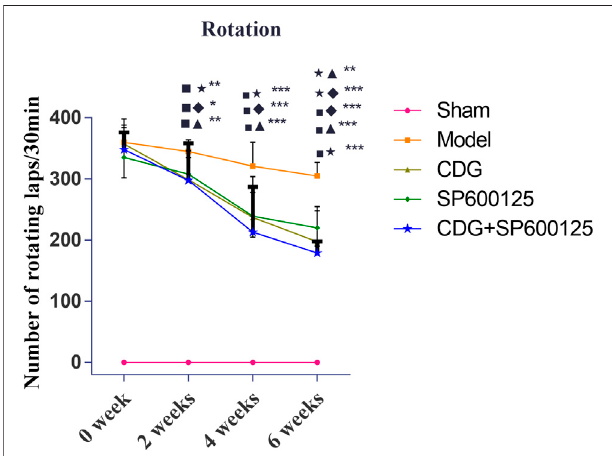
FIGURE5| Comparisonofthenumberofrevolutionsofeachgroupat0, 2,4,and6 weeks.Statisticalanalysiswasperformedwithrepeatedmeasures and multivariate analysis of variance (ANOVA), n (cid:1) 9. Signi fi cant differences were indicated by * p < 0.05; ** p < 0.01; *** p < 0.001.